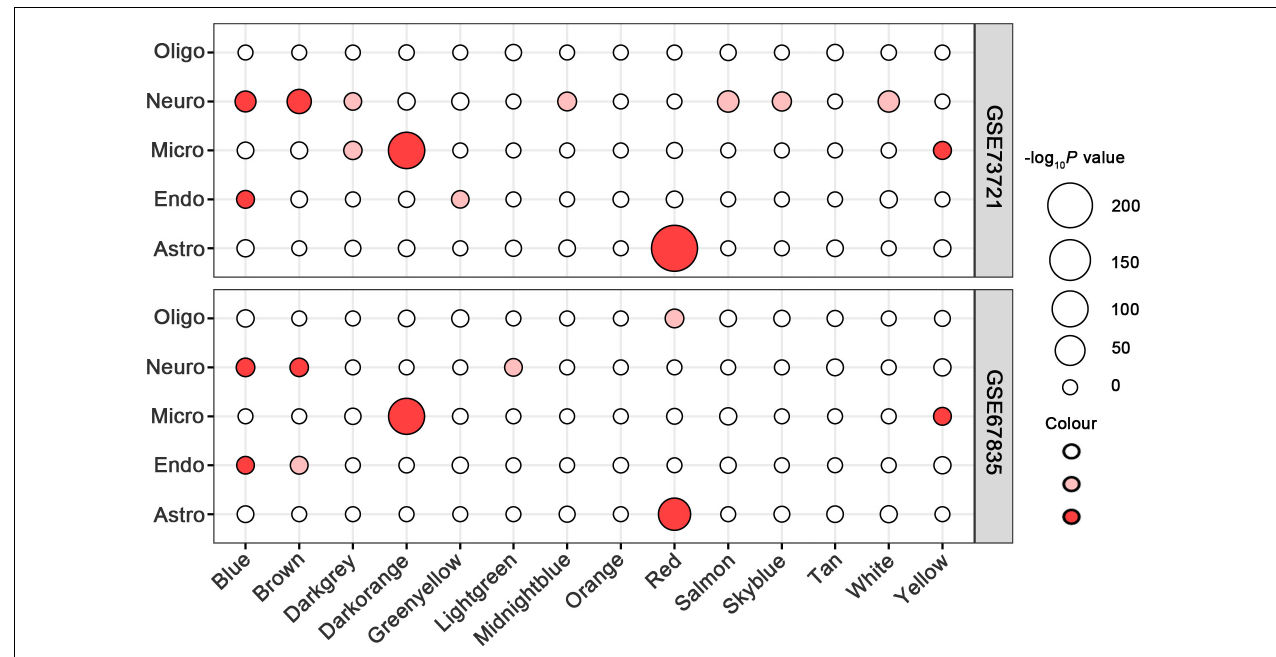
FIGURE 3 | Cell-type-specific analyses for ReHo-related modules in the GSE73721 and GSE67835 series. The size of a given circle corresponds to the cell-type-specific enrichment -log 10 Bonferroni-corrected P -values for each module. Solid red indicates significant enrichment in both series, faint red indicates significant enrichment in only one series, and white indicates non-significant in neither series. GSE, gene series expression; ReHo, regional